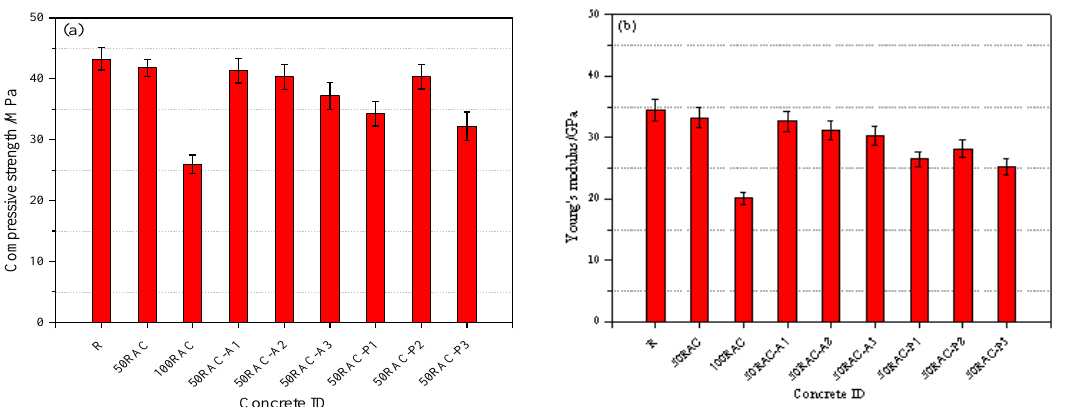
Figure 5. Static properties of concrete after 28 days of curing: ( a ) compressive strength and ( b ) Young’s modulus.